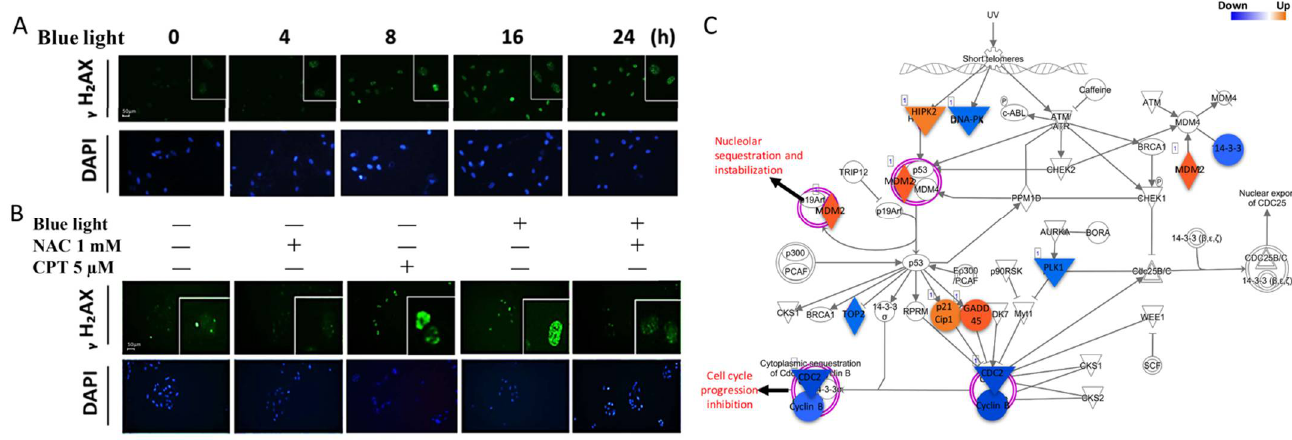
Figure 3. Blue-light-induced ARPE-19 cell DNA damage. ( A ) DNA damage was evaluated by detecting the immunofluorescence intensity of the presented marker, γH2AX. The blue light exposure time was 0 to 24 h (magnification: 40×; enlarged: 200×). ( B ) To confirm the role of ROS generation in DNA damage regulation, the ROS inhibitor NAC (1 mM) was utilized to determine the alteration in DNA damage. CPT (cisplatin; 5 µM) was used in the positive DNA damage control group (magnification: 40×; enlarged: 200×). ( C ) IPA of RNA sequencing showed the molecules potentially involved in ARPE-19 cells regulated by blue light exposure. Blue: decreased gene expression; orange: increased gene expression.